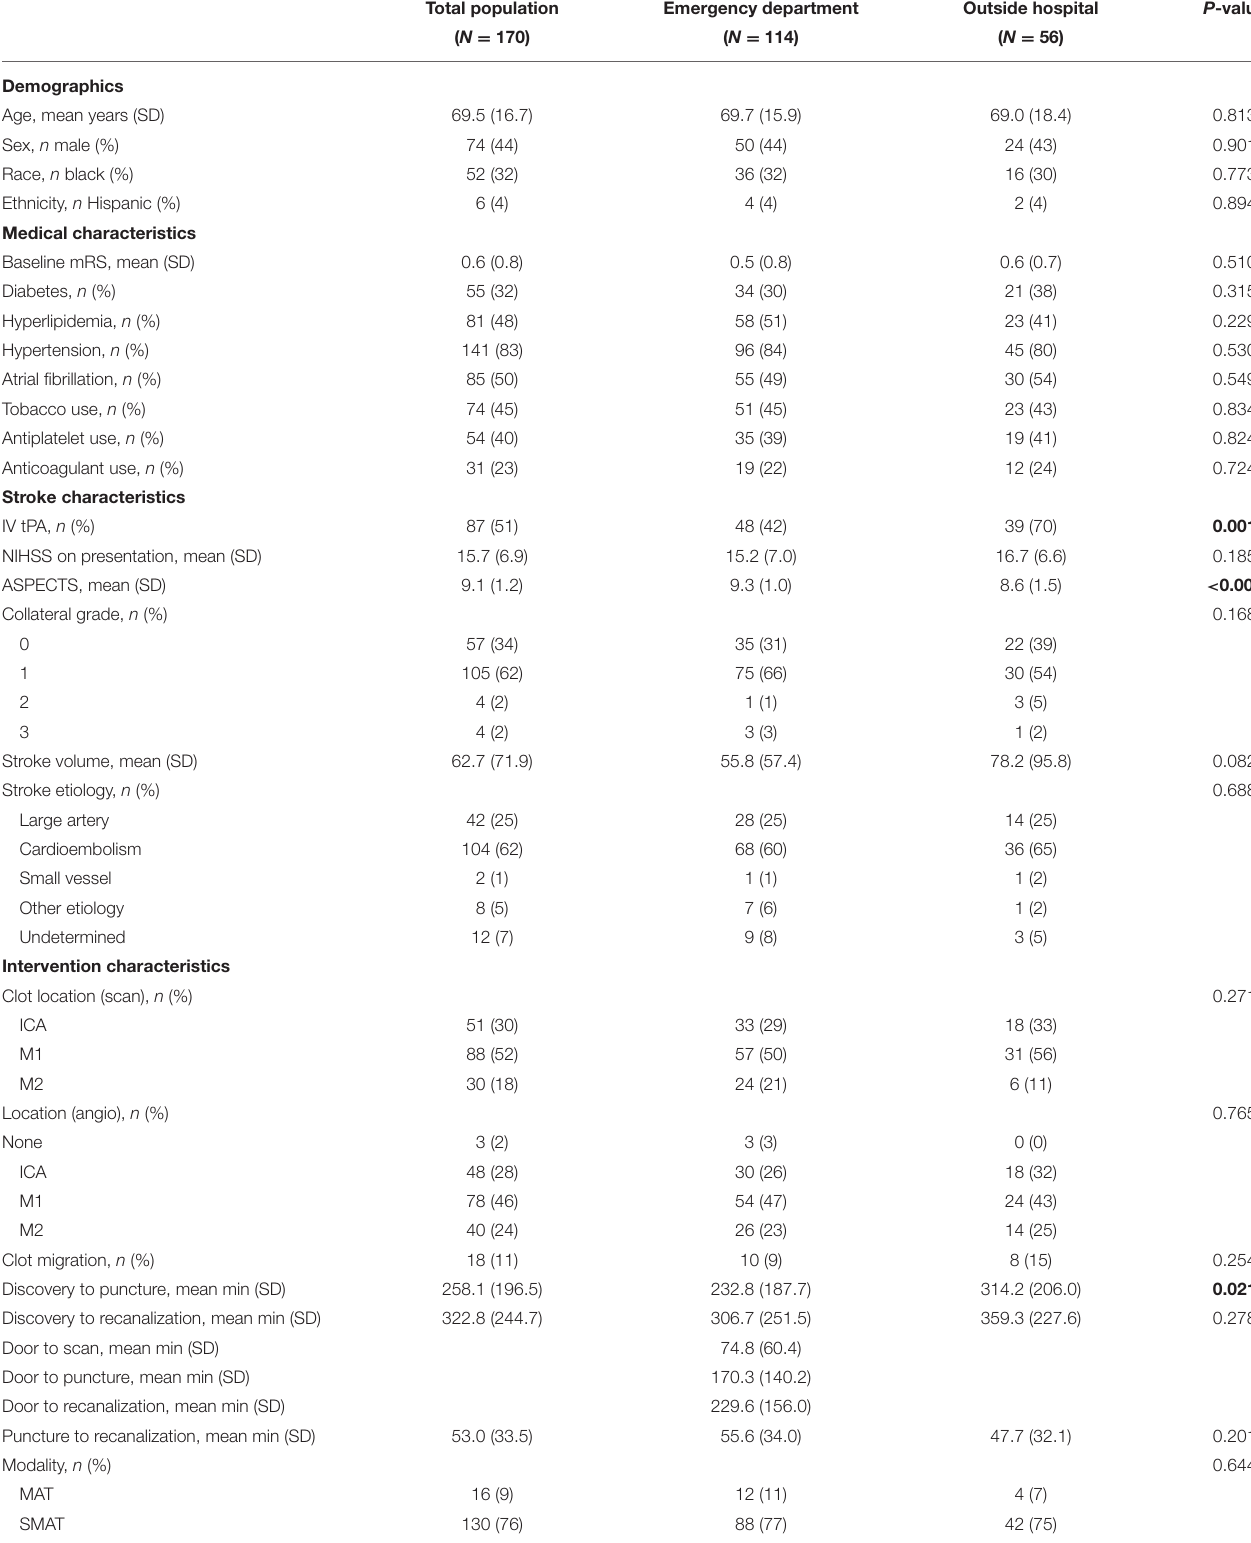
TABLE 1 | Patient